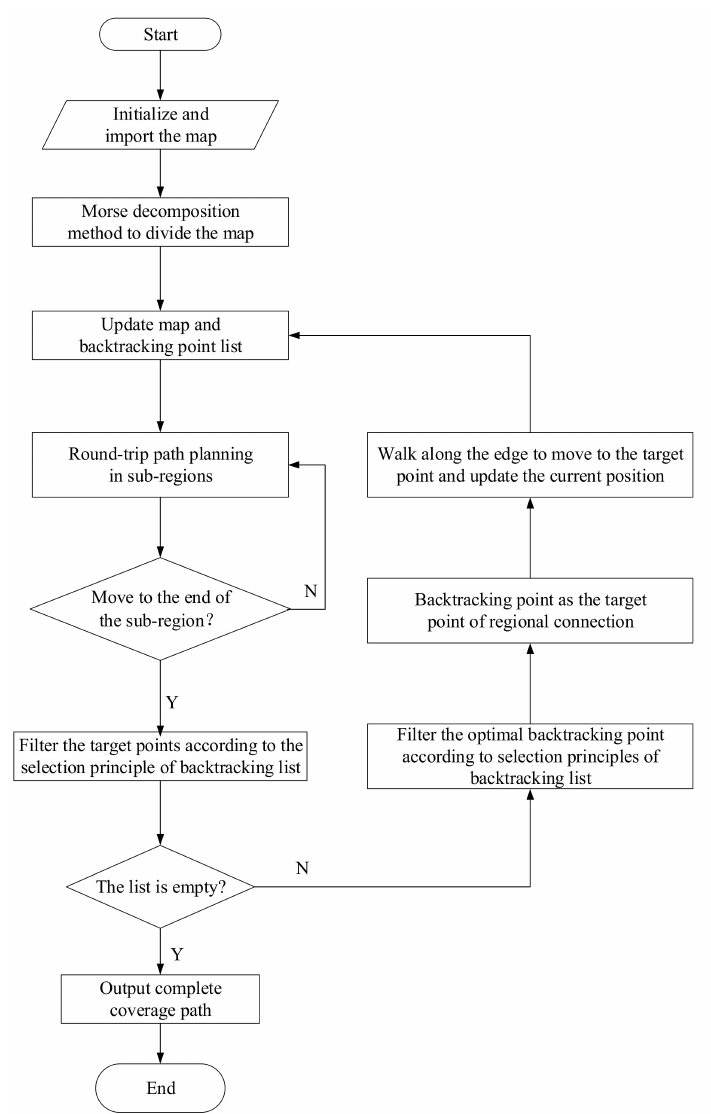
Figure 6. Flow chart of CCPP based on backtracking